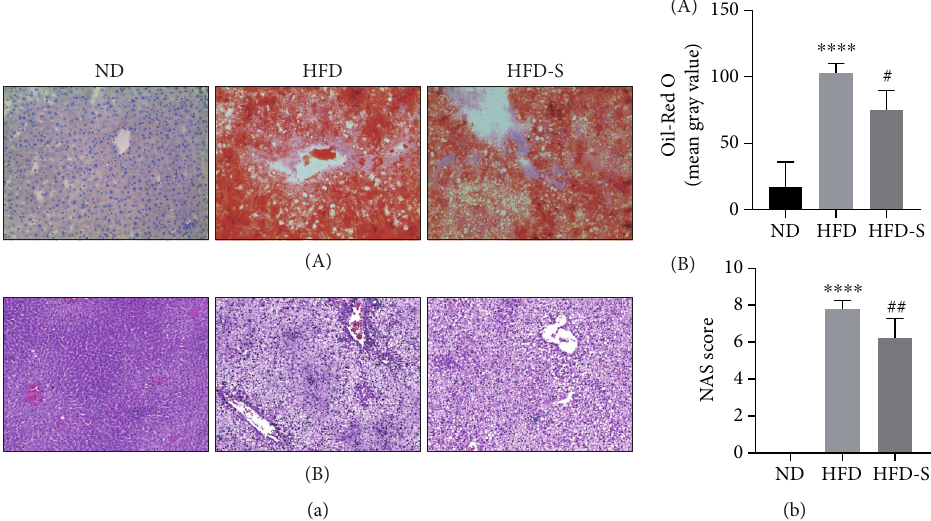
Figure 10: Hepatic pathology results ( n = 5 , mean ± SD ). (a) The hepatic pathology results. (A) The Oil Red O staining ( × 100). B The HE staining ( × 200). (b), (A) The results of semiquantitative Oil Red O staining. (B) The NAS score results. ∗∗∗∗ p < 0 : 0001 vs. ND; ## p < 0 : 01 vs. HFD.